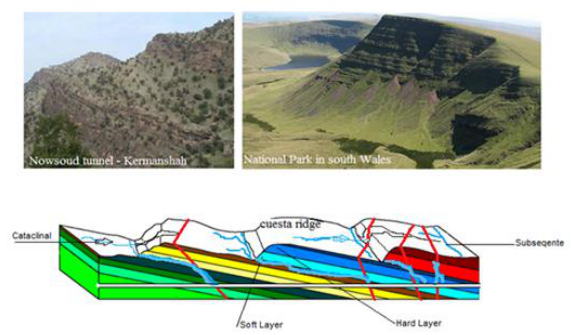
Fig 4. Structural and morphological characterization of cuesta in the study area.